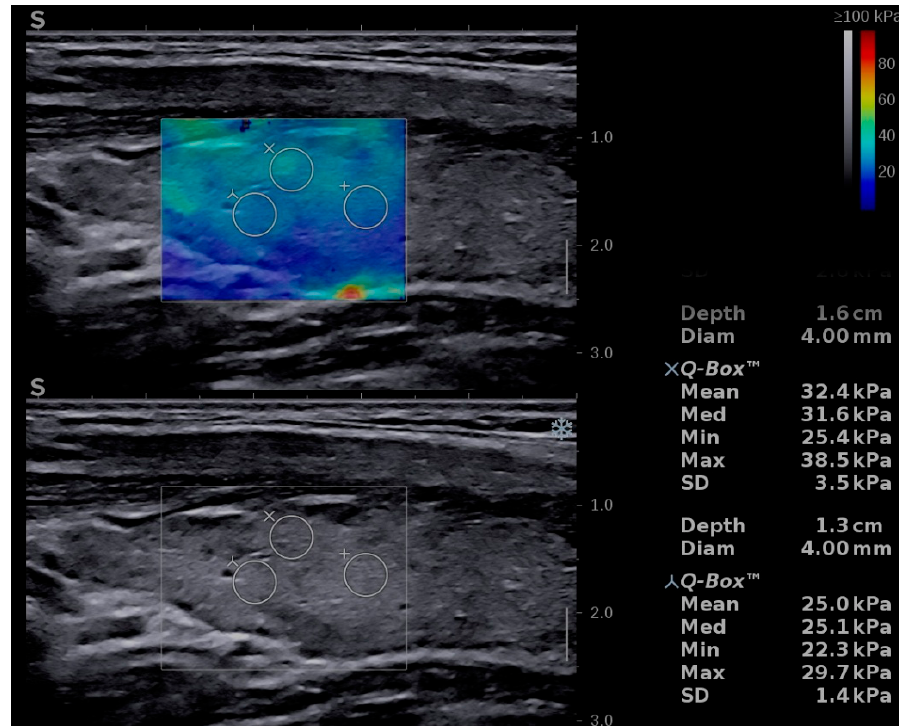
Figure 2. Shear-wave elastography of a girl, 16 years old—from the chronic autoimmune thyroiditis (CAT) group.